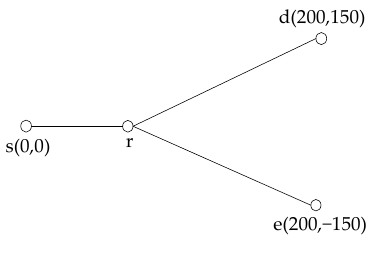
Figure 2. Model used for simulation.